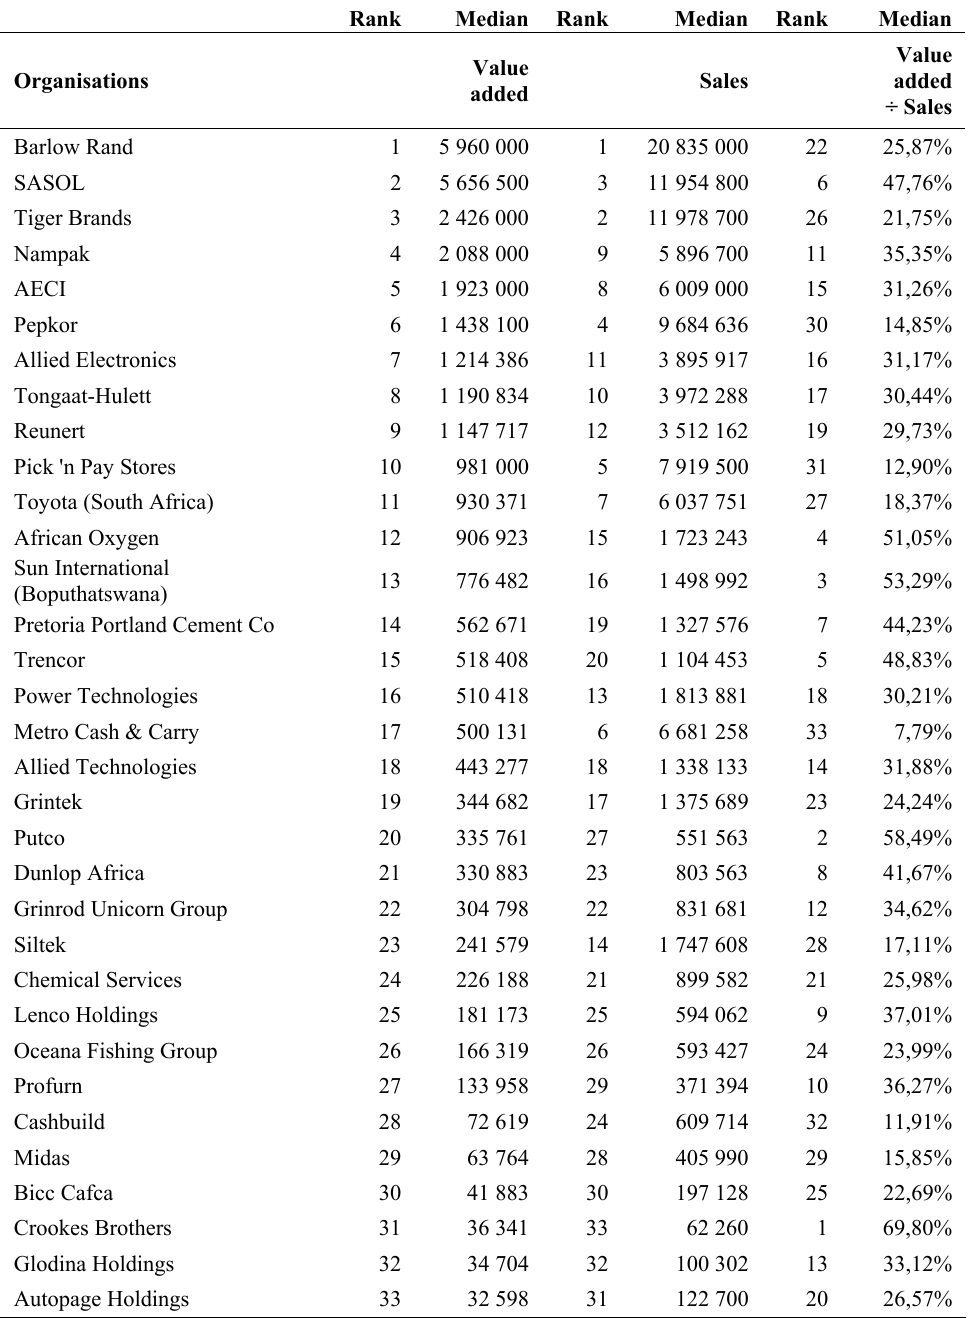
Table 1: Organisations ranked by value added (R’000) – Median